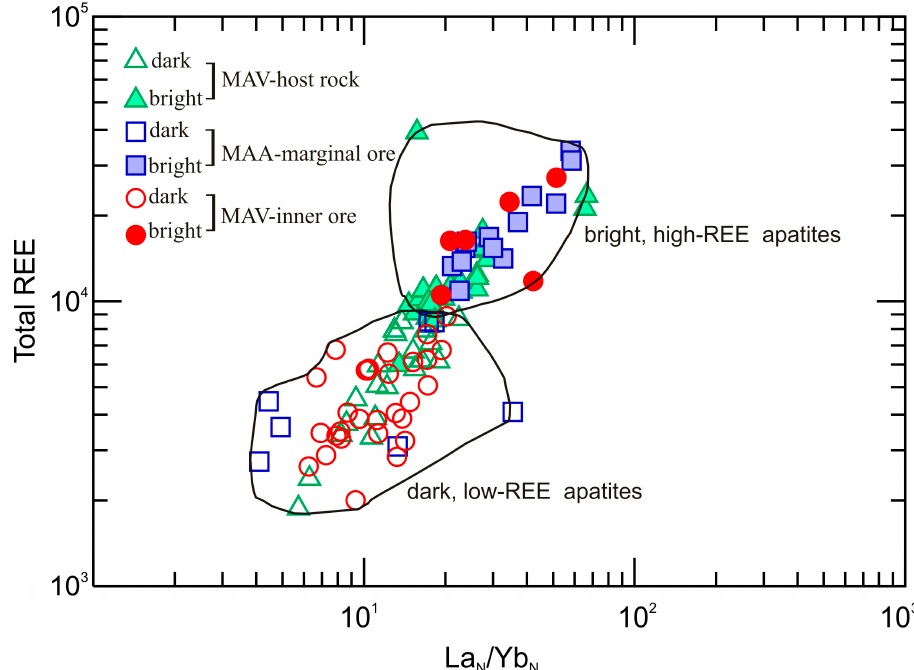
Figure 13. La N/ Yb N ratio (as monitor of the fractionation degree of the REE) vs. total REE concentrations (ppm) for the Chadormalu apatites.